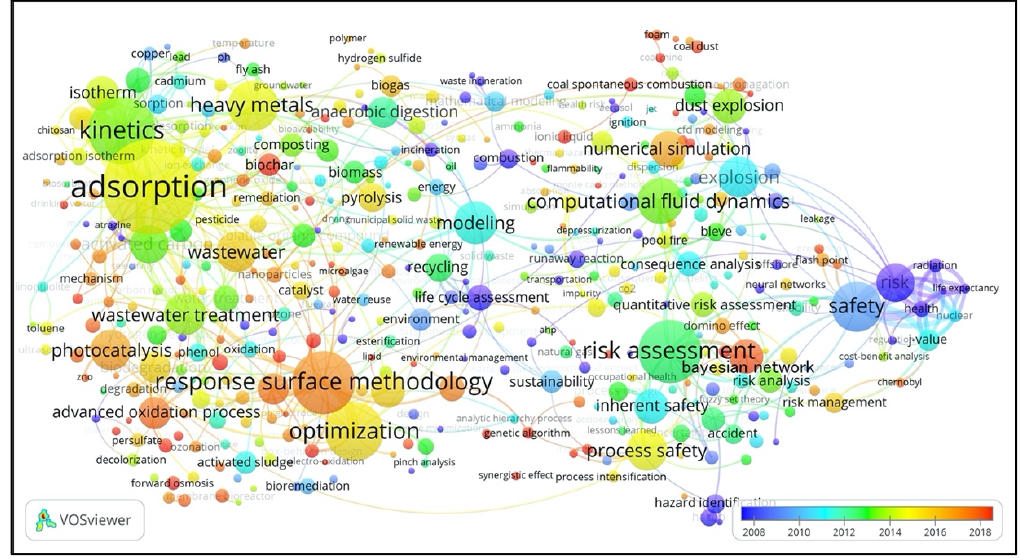
Figure 9. The evolution of PSEP research keywords over time based on the average publication year.